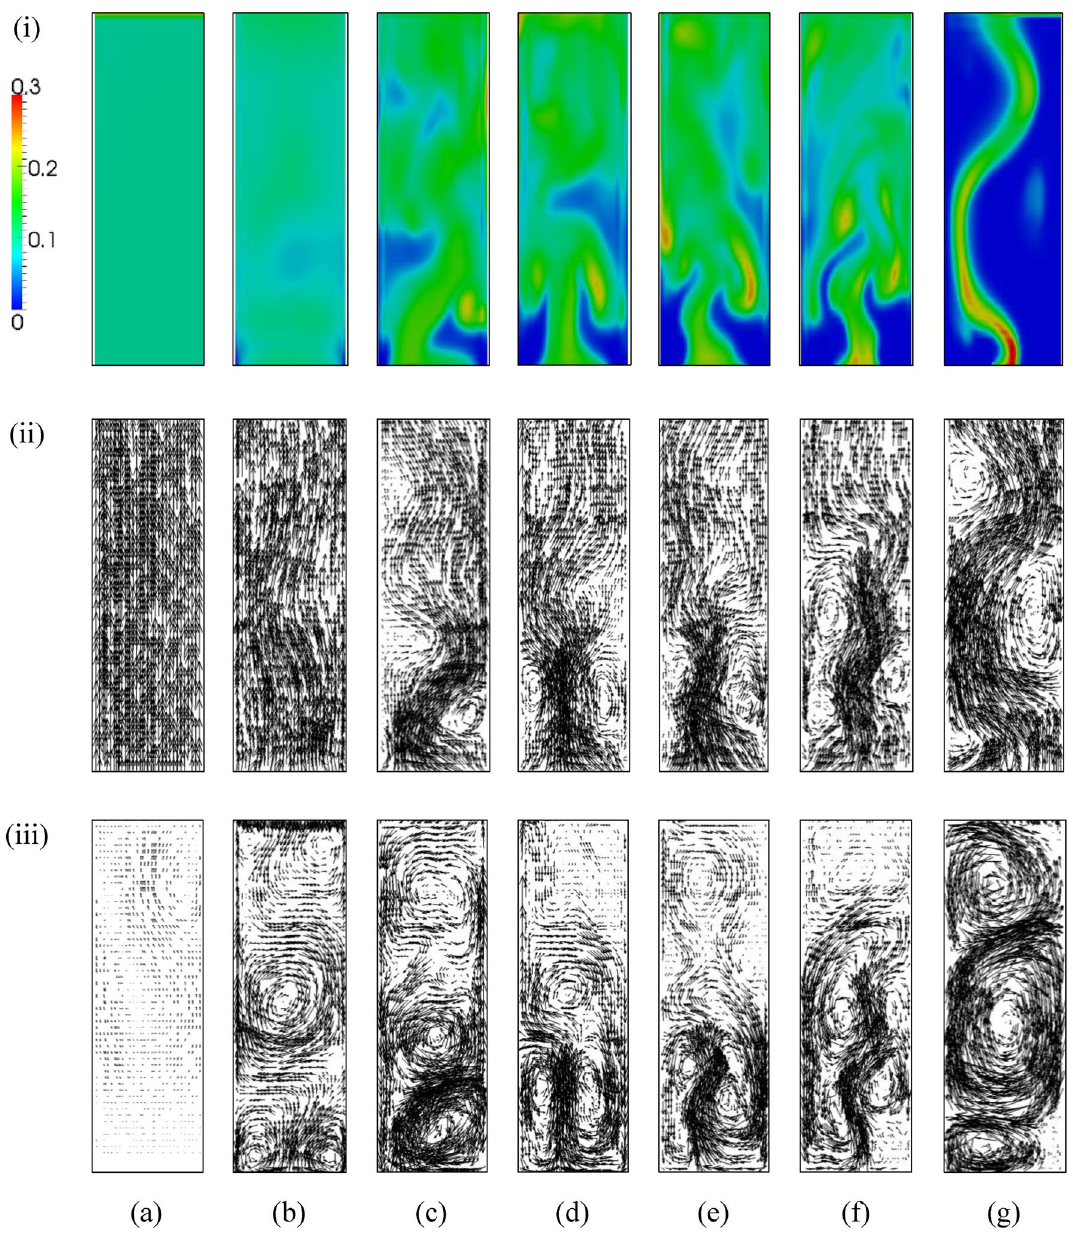
Fig. 7 Simulated (i) gas volume fraction distribution, (ii) gas velocity vectors and (iii) liquid velocity vector for different spargers a A1 (100%), b A2 (95%), c A3 (85%), d A4 (69%), e A5 (59%), f A6 (44%) and g A7 (18%) (U